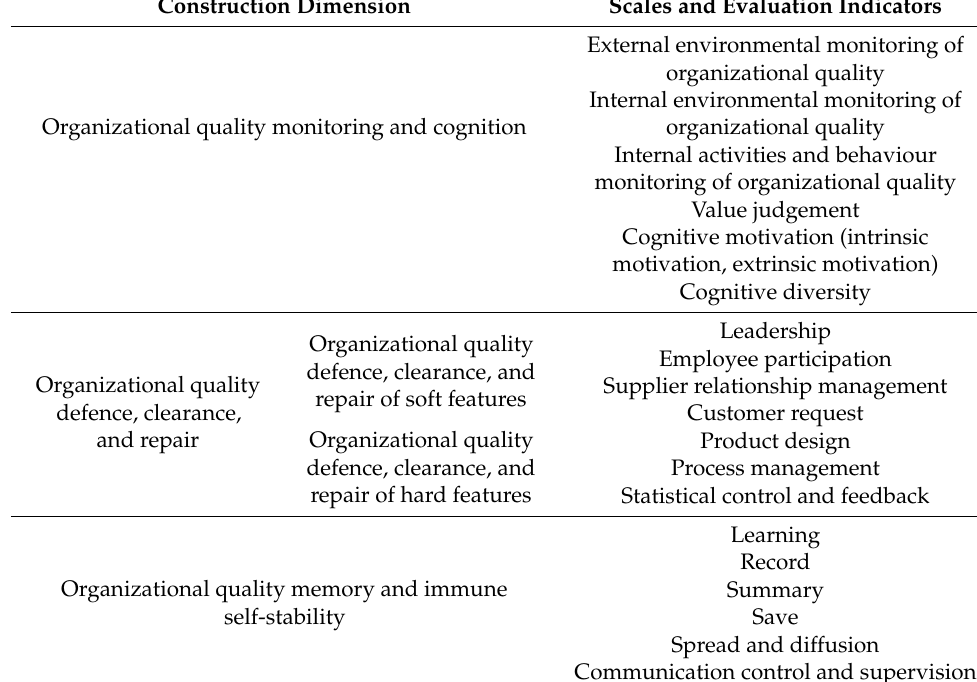
Table 1. Evaluation indicator system for organizational quality-specific